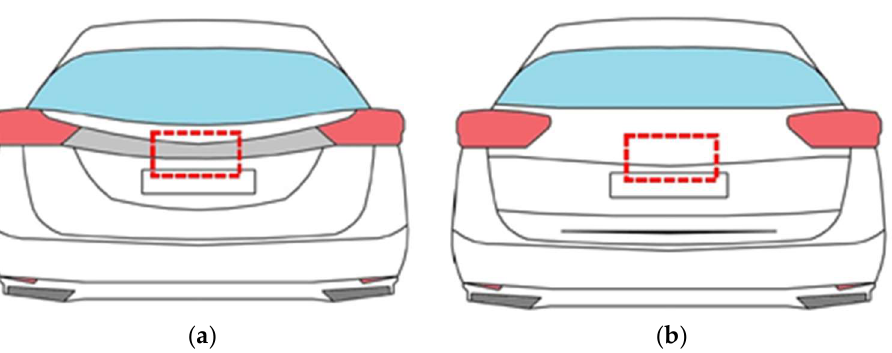
Figure 9. Diagram showing the place of installation of the boot lid contactor (marked with a red line); ( a ) vehicle before modification (has a chrome strip), ( b ) vehicle after modification (without the